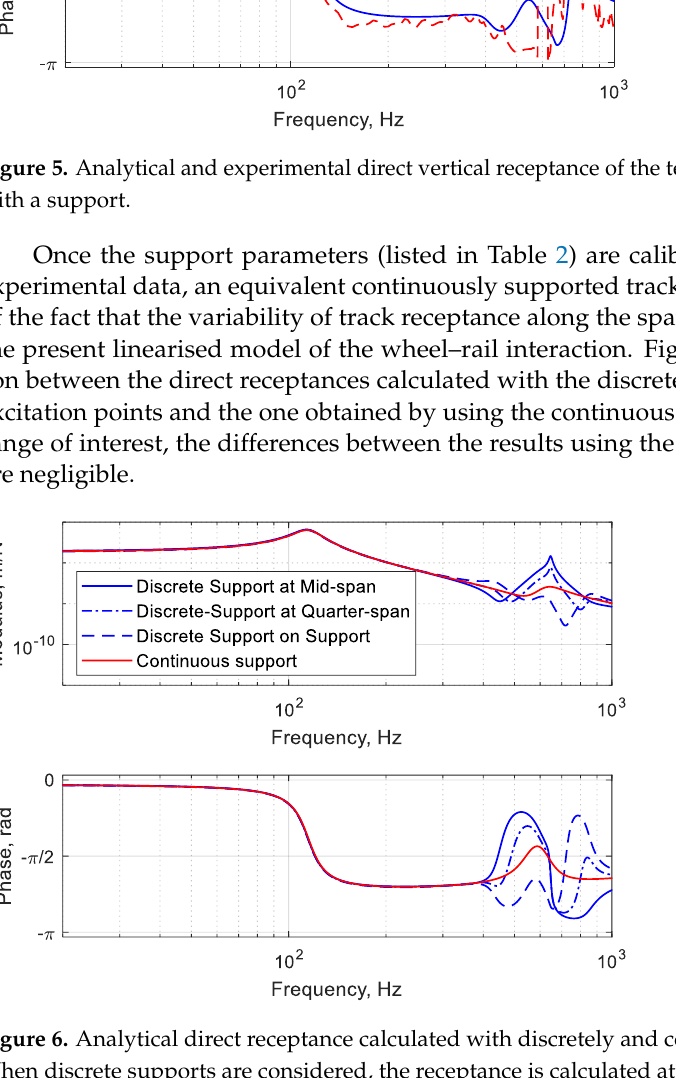
Figure 5. Analytical and experimental direct vertical receptance of the tested track in correspondence with a support.